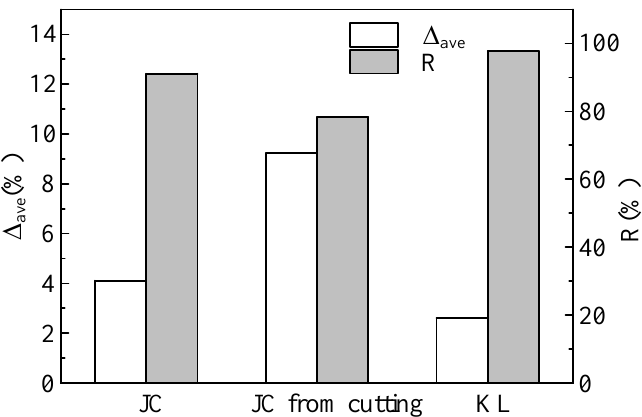
Figure 9. Comparison of correlation coefficient (R) and average absolute error (∆ ave ) of different models in prediction of experiment data.